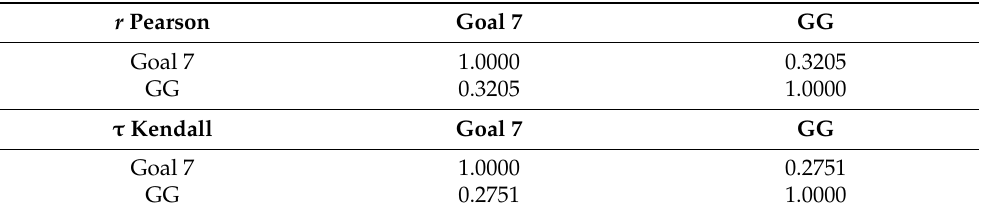
Table 5. Correlation coefficient matrix r Pearson and τ Kendall, respectively, for the values of the synthetic measures determined and the positions held in the built